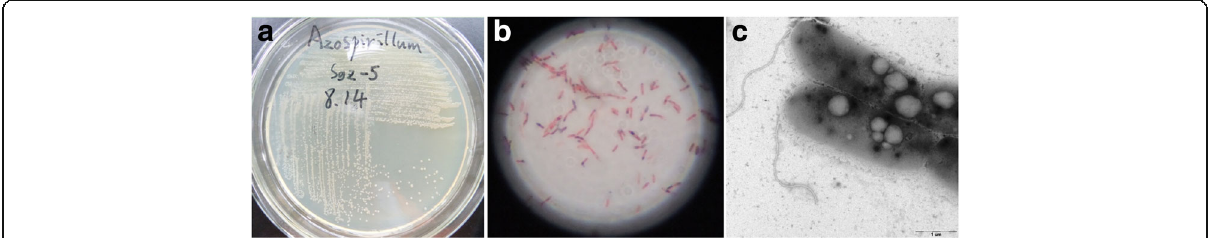
Fig. 1 Images of the A. humicireducens SgZ-5 T . a Colonies of the strain on NA agar plate, b light microscopy and c transmission electron microscopy of the strain